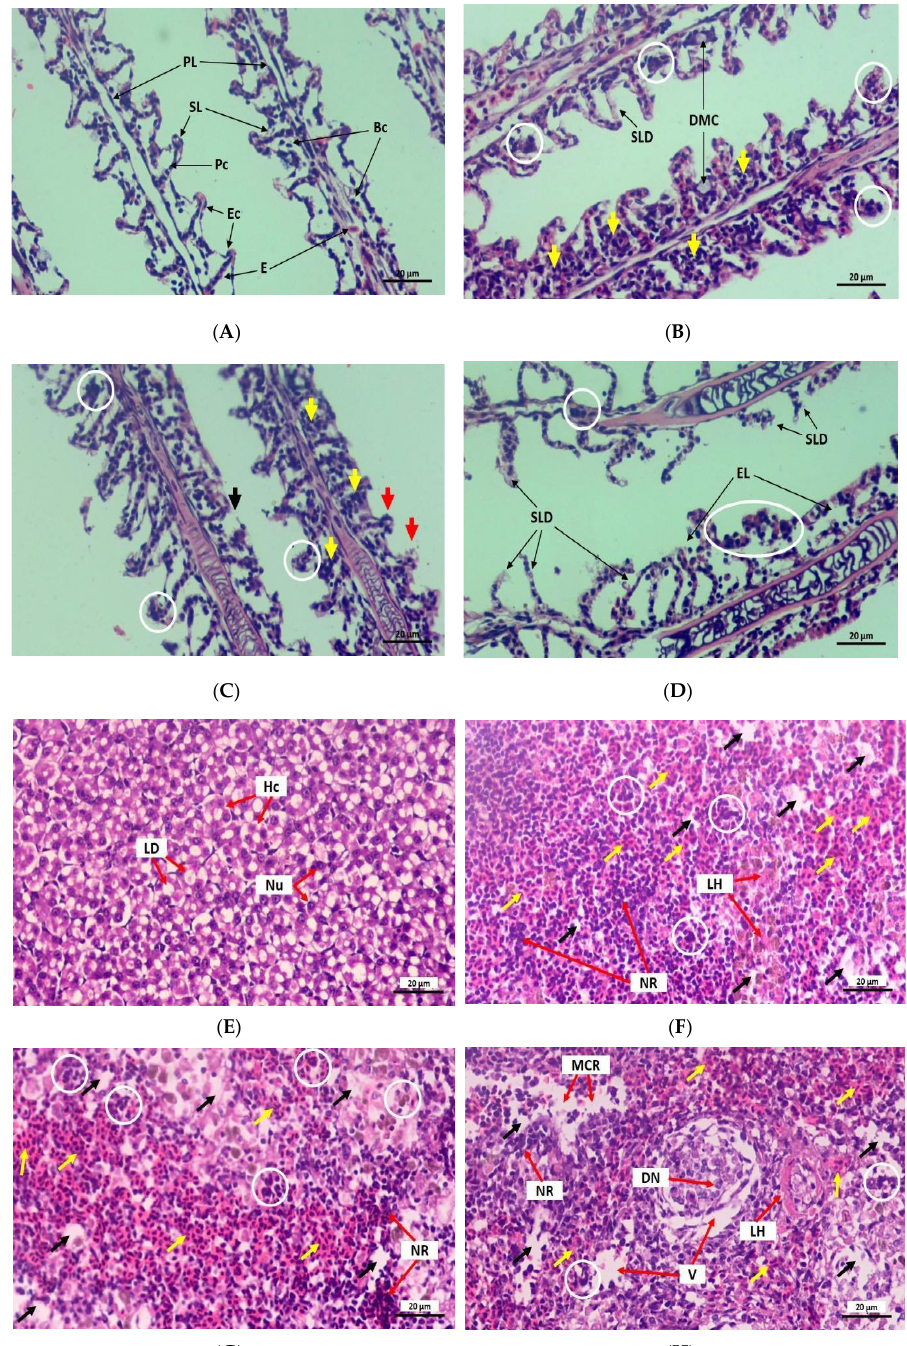
Figure 6. Longitudinal microscopic view of gills. ( A ) Control, ( B ) T 1 , ( C ) T 2 , ( D ) T 3 (PL — primary lamellae, SL — secondary lamellae, Pc – pillar cells, Ec — epithelial cells, E — erythrocytes, Bc — basal cells, DMC – diffusion of mucous cells, SLD — secondary lamellae damage, EL — epithelial lifting; white circle — acute necrosis, yellow arrows — congestion of basal cells, red arrows — shortening sec- ondary lamellae, black arrows — damage of epithelial layer). Transverse photomicrographs of liver. ( E ) Control, ( F ) T 1 , ( G ) T 2 , ( H ) T 3 (Hc — hepatocytes, Nu — nuclei, LD — lipid droplets, LH – liver haem- orrhage, NR – nuclear ruptures, DN — degenerated nuclei, MCR — massive cell rupture, V — vacuole; white circle — necrosis, black arrows — cell rupture, yellow arrows — erythrocyte infiltration in blood sinusoids).